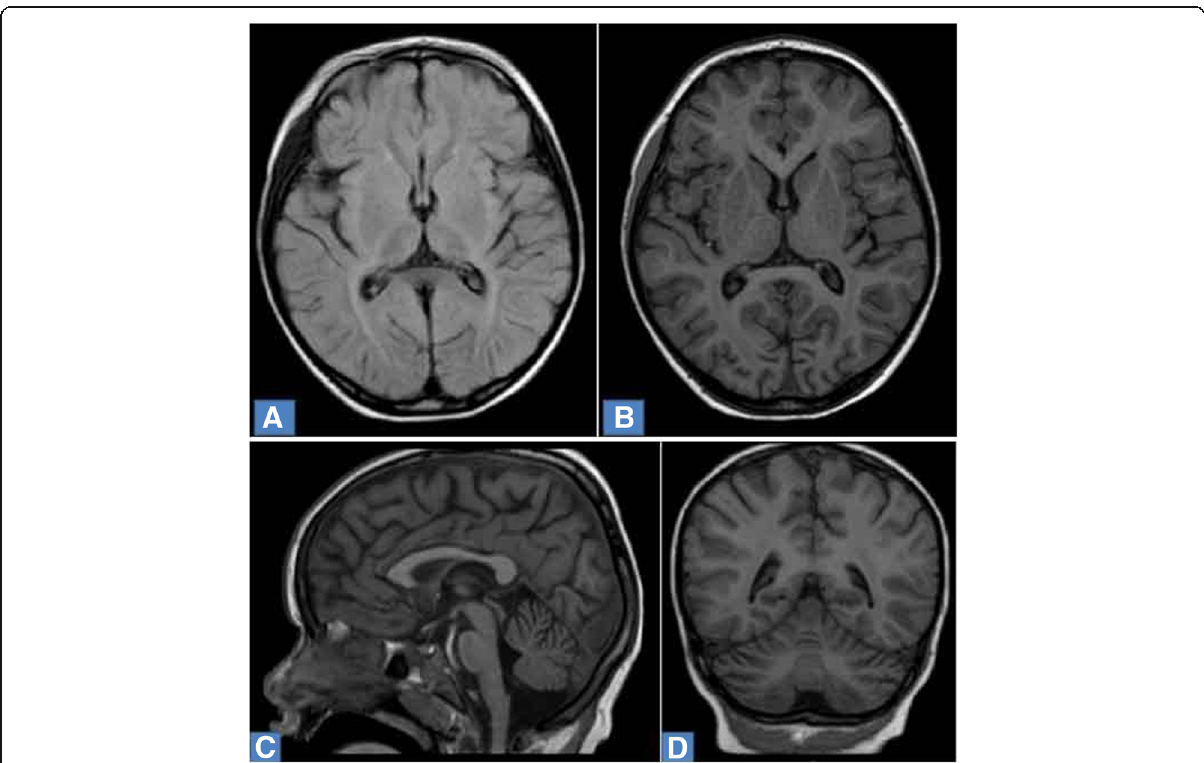
Fig. 1 Brain MRI of 5-year-old girl with NCL7. a . Diffuse cortical atrophy, increased intensity of the MR signal in periventricular white matter. Axial T2 weighted FLAIR image. b . Diffuse cortical and subcortical atrophy of the brain. Axial T1 weighted image. c . Atrophy of the cerebellum, cortical atrophy of the brain. Sagittal T1 weighted image. d . Diffuse cortical and subcortical atrophy of the brain, atrophy of the cerebellum. Frontal T1 weighted